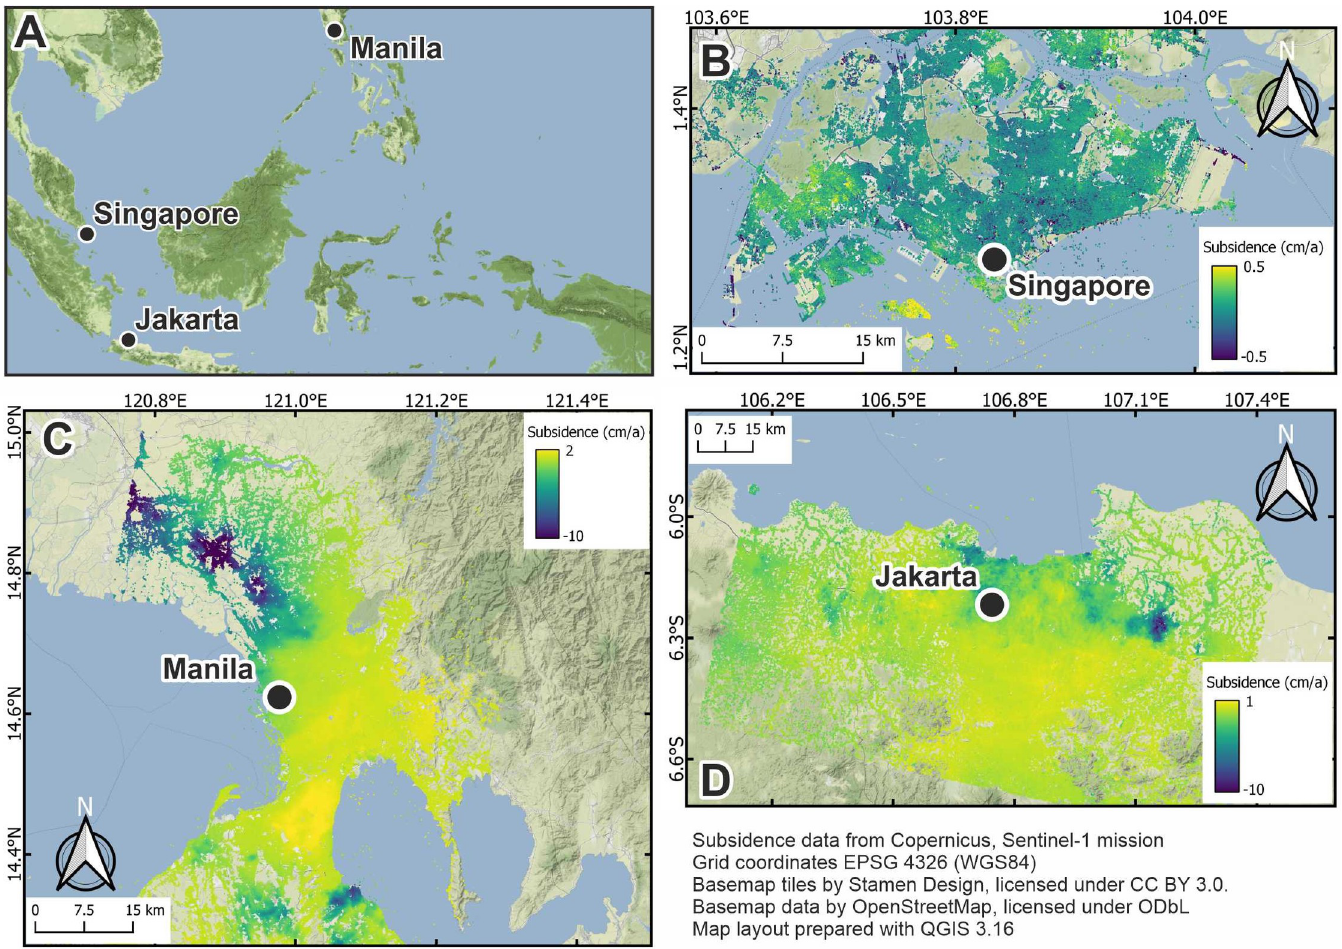
Fig 1. Vertical displacement rates for Jakarta (D), Metro Manila (C) and Singapore (D). Note that Singapore’s displacement is scaled to -2/2 cm/a. Contains Copernicus data 2018.